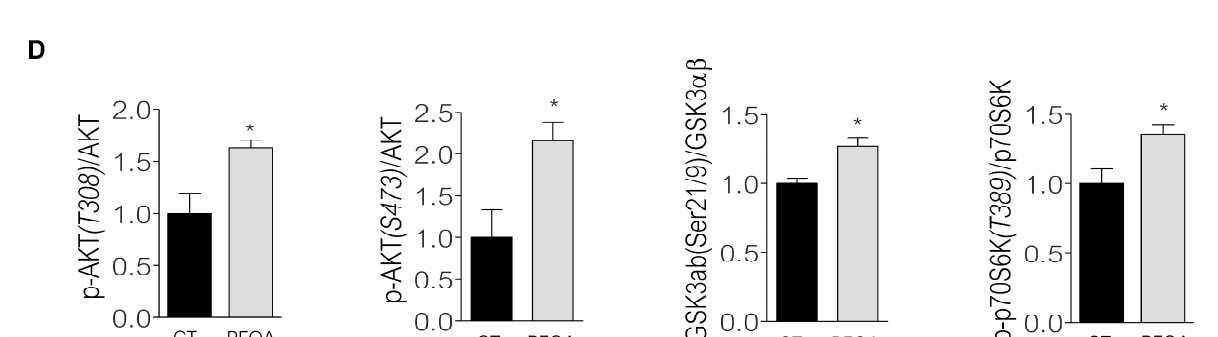
Figure 5. PFOA increases proliferation via Akt and mTORC1 in MCF7 cells. ( A ) Western blot of phospho-p70S6Kinase (Thr389), total p70S6Kinase and Actin of MCF7 cell protein extract after 48 h of treatment with PFOA (10 − 12 M) in comparison with cells treated with EtOH (CT) and overnight exposure with either DMSO or Rapamycin (20 nM or 40 nM). ( B ) Quantification of protein level of three different western blot experiments. ( C ) BrdU cell proliferation assay. Measured proliferation of MCF7 cells after 48 h treatment with PFOA (10 − 12 M) in comparison with cells treated with EtOH (CT) and overnight exposure with either DMSO or Rapamycin (20 nM or 40 nM). Each bar repre- sents a mean ± SEM of 3 independent experiments. ( D ) Western blot of phospho-AKT(Ser473), AKT total and HSP90 of MCF7 protein extract after 48 h of treatment with PFOA (10 − 12 M) in comparison with cells treated with EtOH (CT) and overnight exposure with either DMSO or LY294002 (10 µM or 25 µM) overnight exposure. ( E ) Quantification of protein level of three independent western blot experiments. ( F ) BrdU cell proliferation assay. Measured proliferation of MCF7 cells after 48 h treat- ment with PFOA (10 − 12 M) in comparison with cells treated with EtOH (CT) and overnight exposure with either DMSO or LY294002 (10 µM or 25 µM). Each bar represents a mean ± SEM of 3 independ- ent experiments. * p < 0.05; ** p < 0.005; *** p < 0.0005; ns: non-significant. 3. Discussion